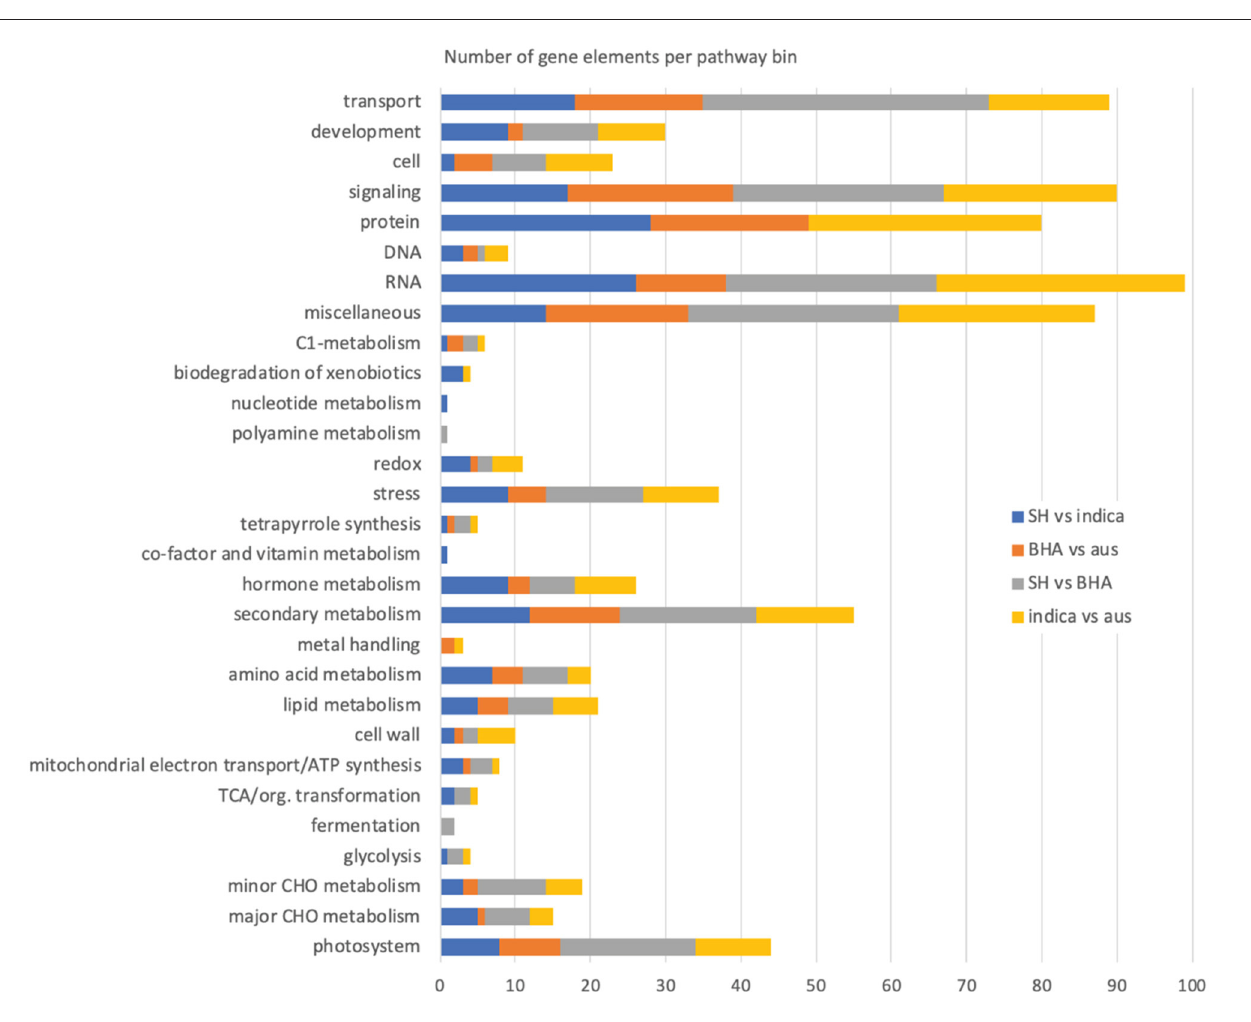
( Table 4 ), many of these falling within the major and minor CHO metabolism MapMan pathway bins ( Supplementary Table 15